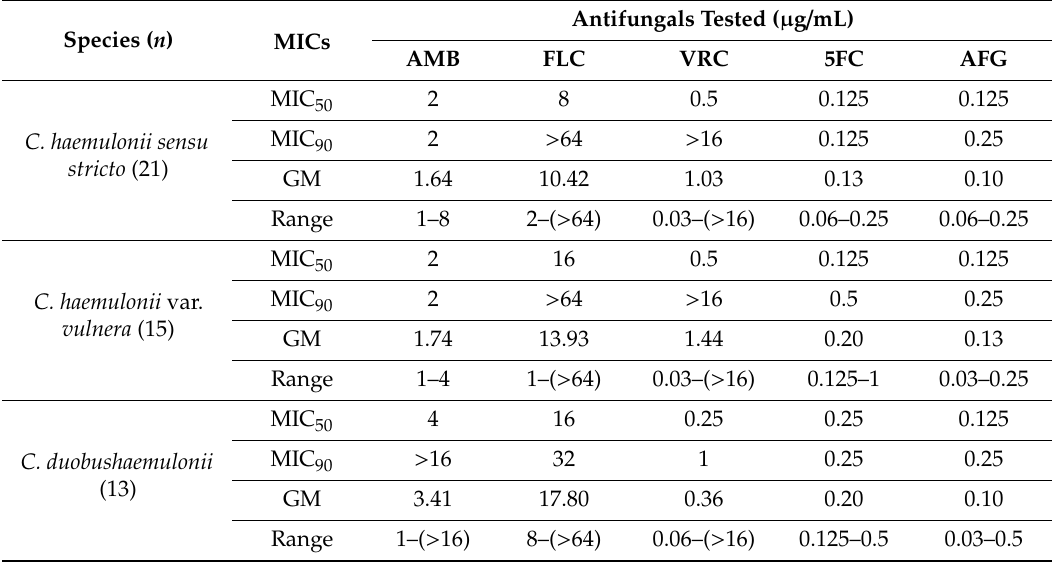
Figure 1. Prevalence rates of C. haemulonii species complex clinical isolates. P1: December 2008 to June 2013; P2: July 2013 to December 2019. Table 1. Antifungal susceptibility testing of 49 C. haemulonii species complex clinical